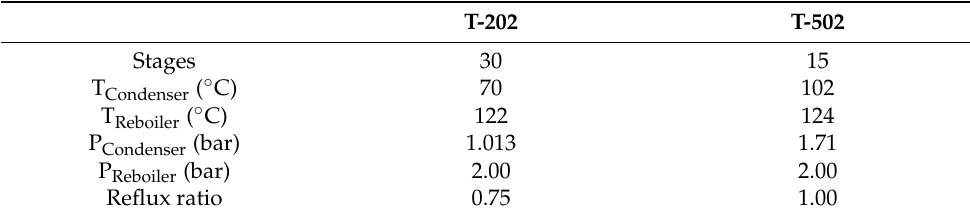
Table 4. Main parameters of the regeneration towers